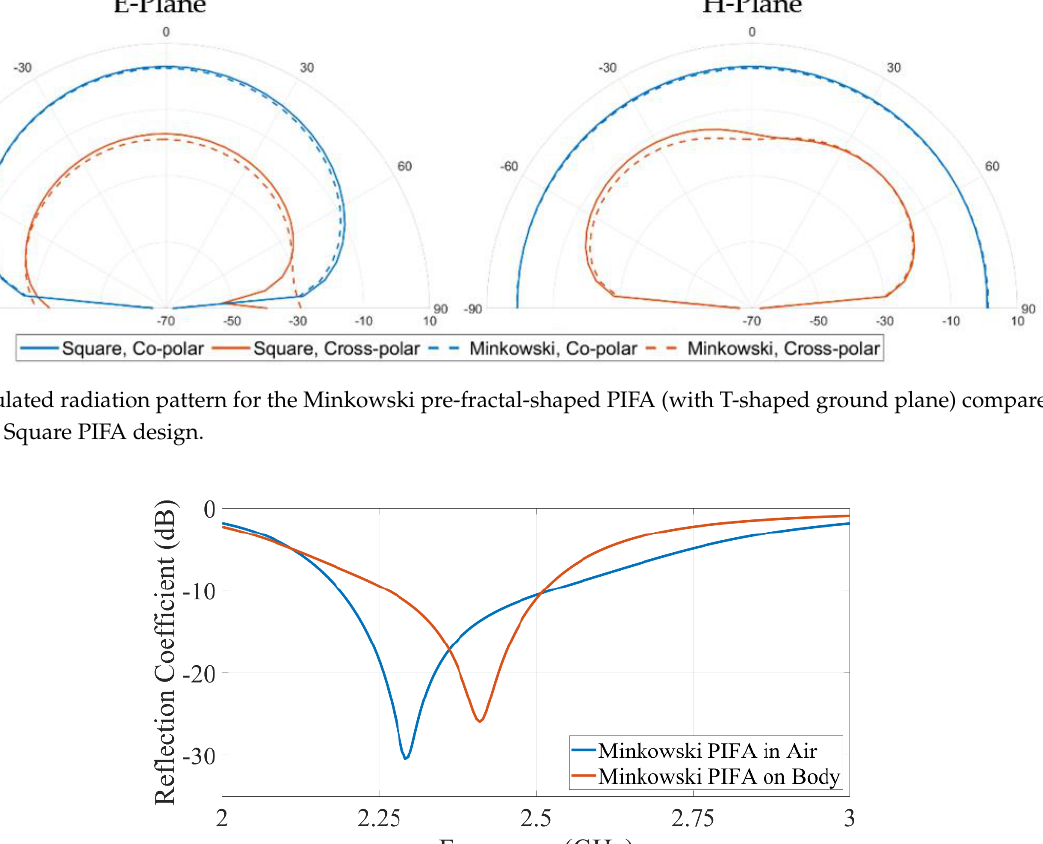
Figure 6. Simulated radiation pattern for the Minkowski pre-fractal-shaped PIFA (with T-shaped ground plane) com- pared to the original Square PIFA design.